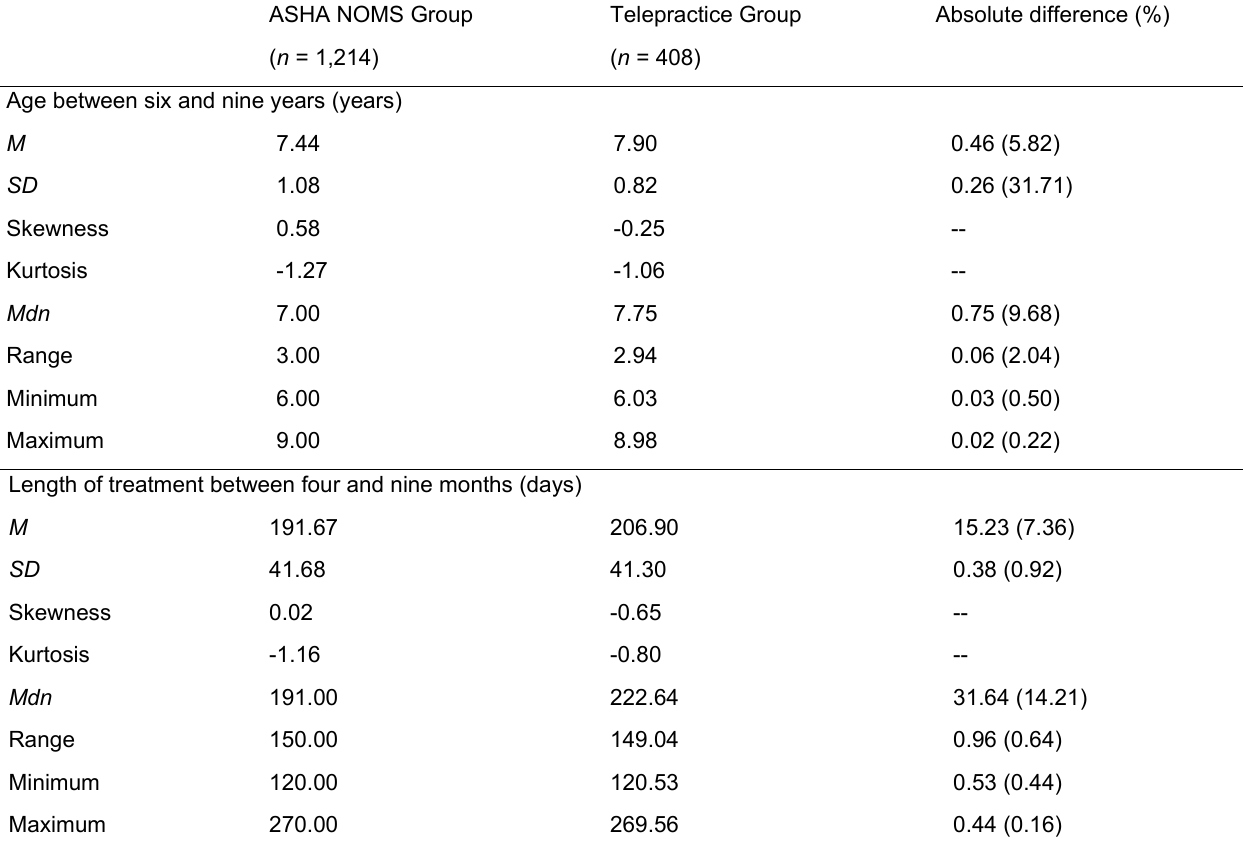
Absolute difference (%)